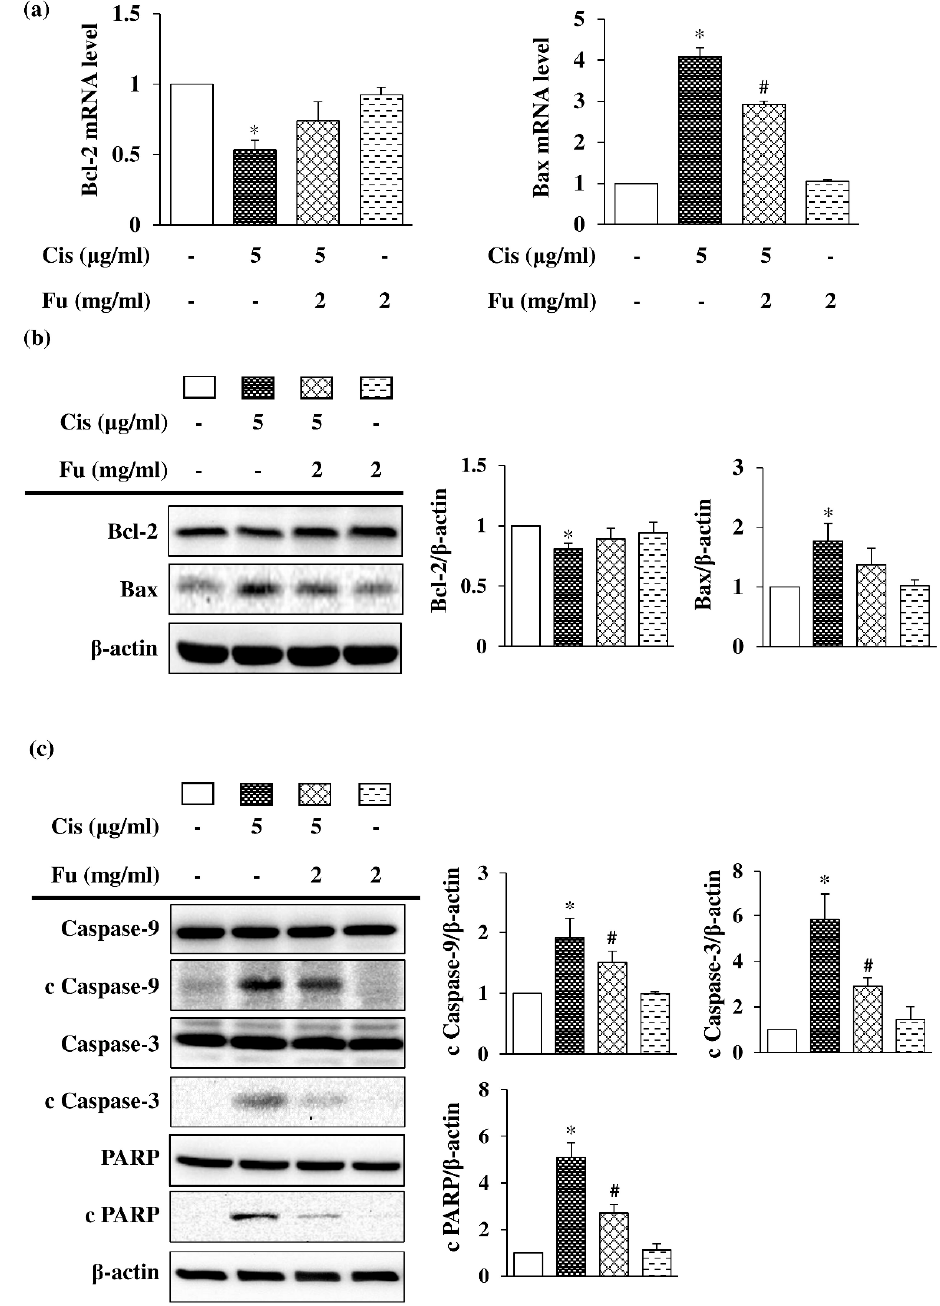
Figure 3. Effects of Fu on Cis-induced apoptosis in UB/OC-2 cells. Cells were cultured with Fu (2 mg/mL) for 2 h, followed by stimulation with Cis (5 µ g/mL) for 24 h. ( a ) The mRNA expression levels of Bcl-2 and Bax were determined via a reverse transcription-quantitative polymerase chain reaction. ( b ) Western blot analysis was used to determine Bcl-2 and Bax expression levels. ( c )